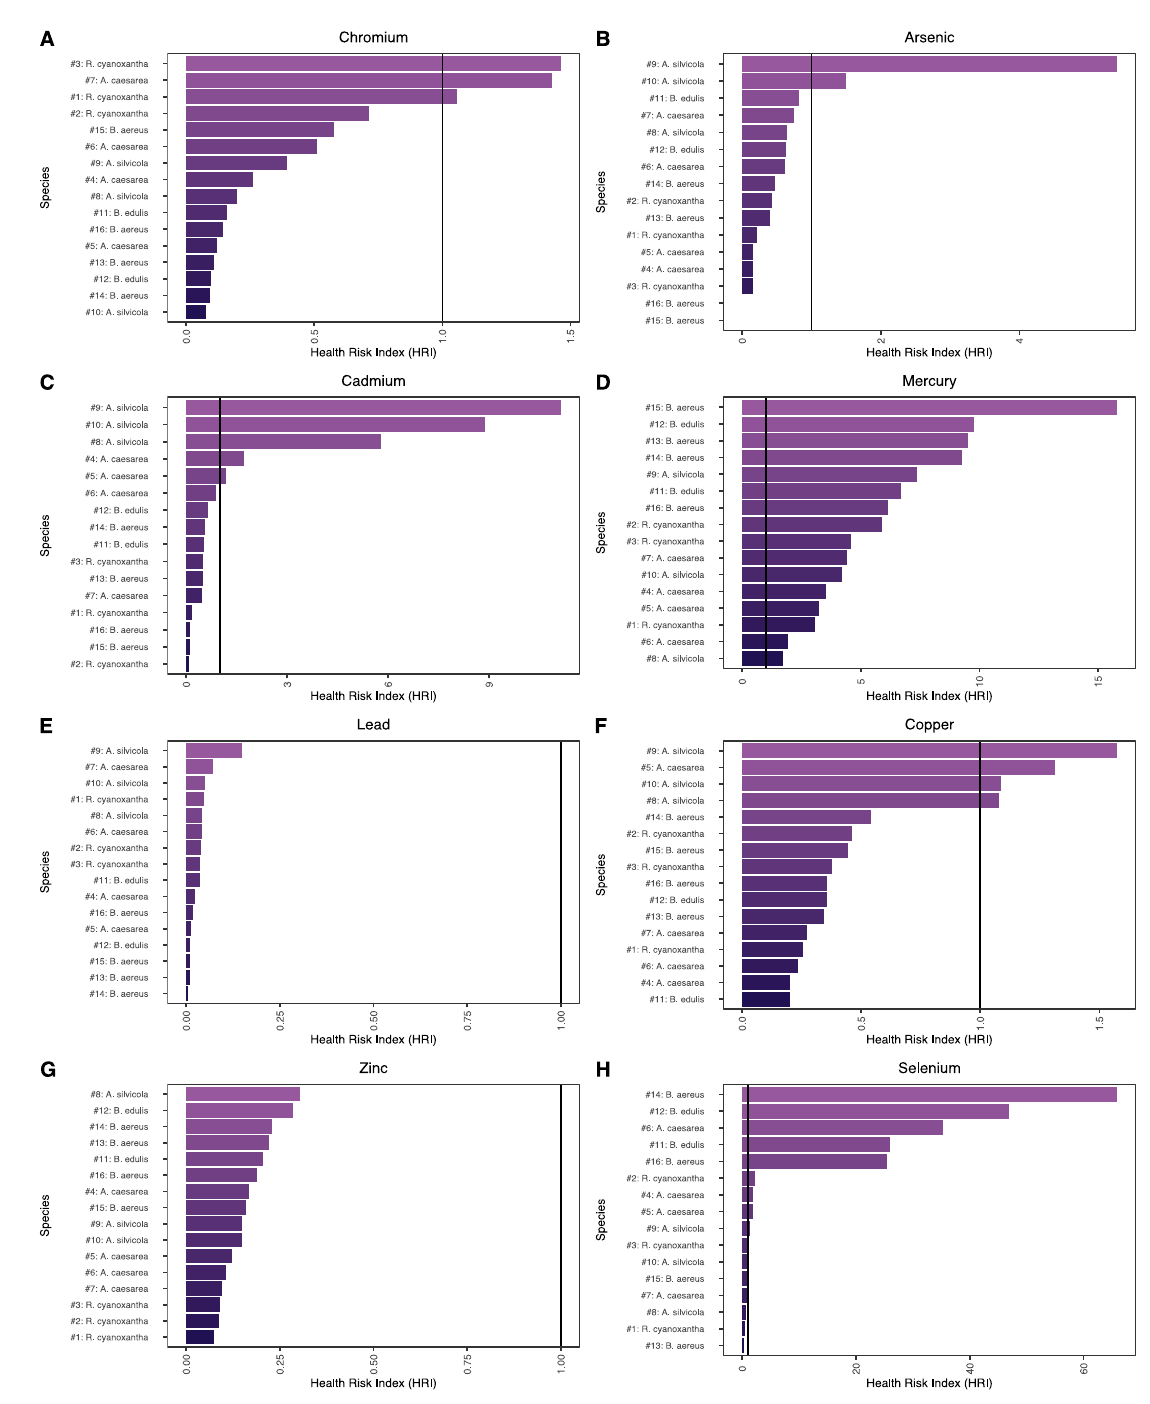
Figure 3. Bar charts of the Health Risk Index (HRI) result according to metallic elements and metalloids determined for all the wild edible mushroom species studied: ( A ) Cr HRIs; ( B ) As HRIs; ( C ) Cd HRIs; ( D ) Hg HRIs; ( E ) Pb HRIs; ( F ) Cu HRIs; ( G ) Zn HRIs; ( H ) Se HRIs. The HRI limit has been represented with the help of a vertical black line in the bar